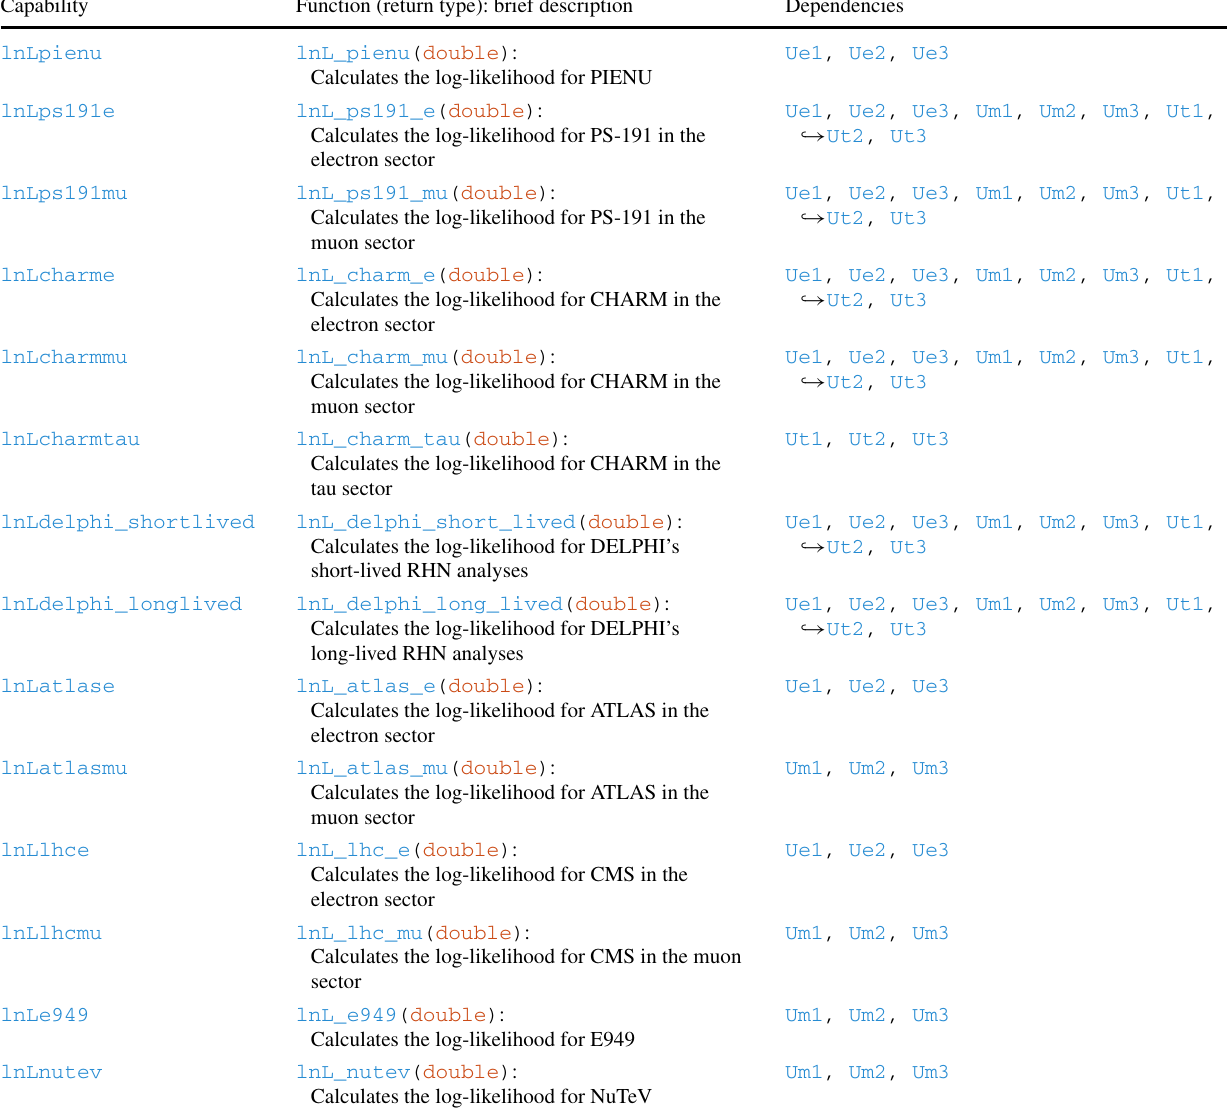
Table 19 Capabilities and module functions implemented in NeutrinoBit to calculate direct search likelihoods for sterile neutrino models Capability